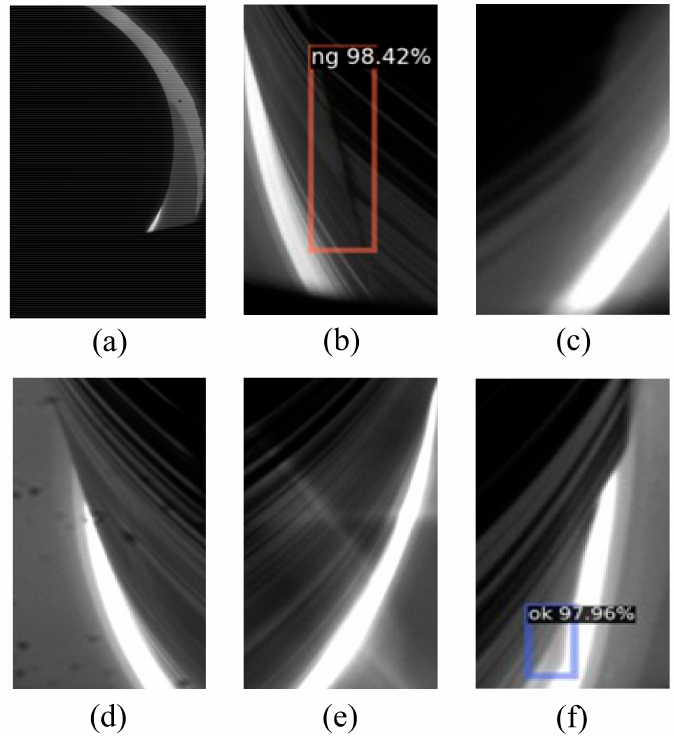
Figure 11. ( a – f ) Sample images that are prone to